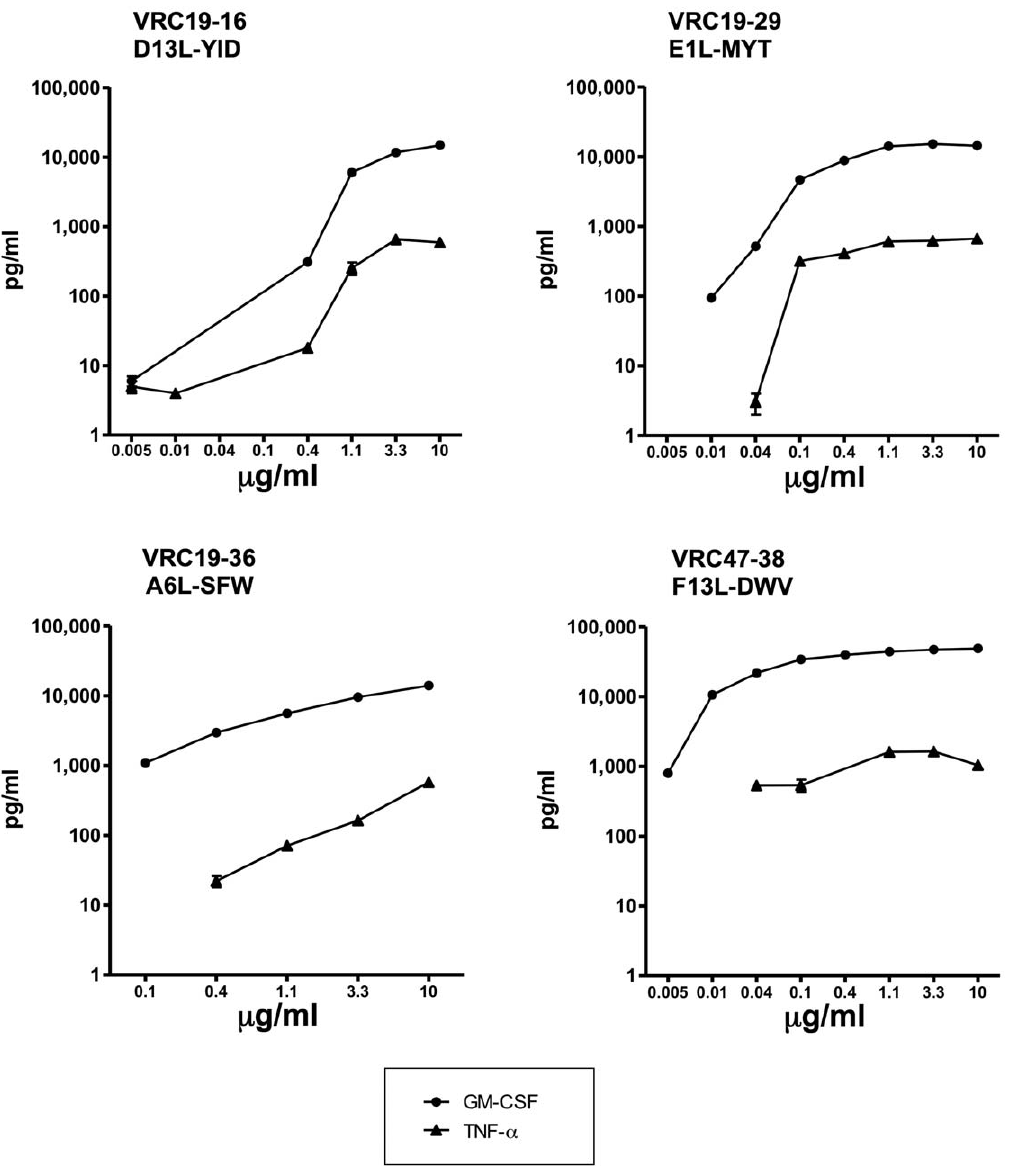
Figure 4. GM-CSF and TNF- a production by vaccinia specific CD4 + T cell clones in response to the identified vaccinia peptides. Each vaccinia CD4 + T cell clone (2.5 6 10 4 ) was stimulated for 48 hours in the presence of autologous LCL (5 6 10 4 ) and peptide in a dose response assay at the indicated concentrations. GM-CSF and TNF- a was measured in the culture supernatants by ELISA. Values represent the average cytokine production in two independent duplicate wells and are derived from one representative experiment out of